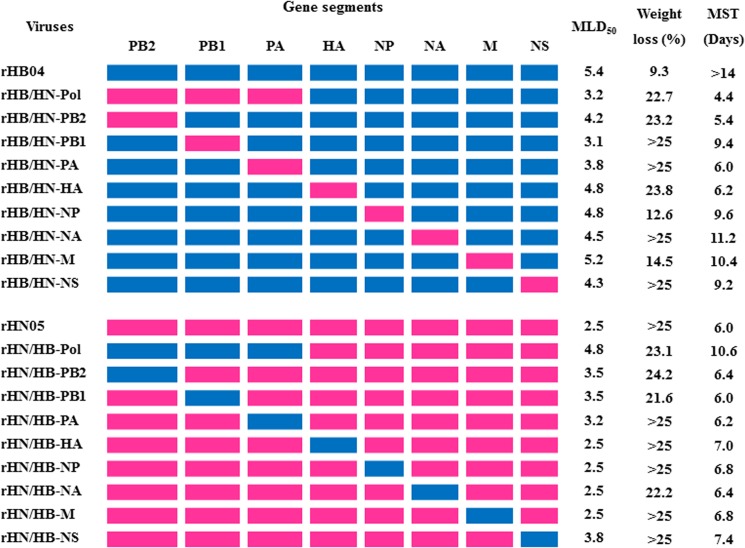
Pathogenicity of rescued reassortant viruses in mice.Colored bars indicate viral gene segments. Segments derived from HB04 and HN05 are shown in blue and red, respectively. The MLD50 of the rescued viruses was determined as described in the Materials and Methods section. The mean maximum weight loss was determined from five mice (percentage weight loss relative to day 0 p.i.) after infection with 105 TCID50 of virus. The mean survival time (MST) of mice infected with 105 TCID50 was calculated using the Kaplan-Meier method.